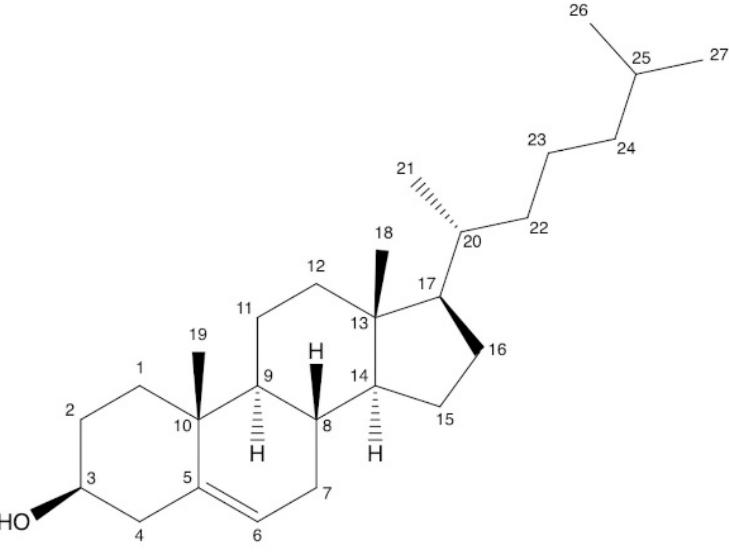
Figure 1. Cholesterol with carbon numbering according to IUPAC.